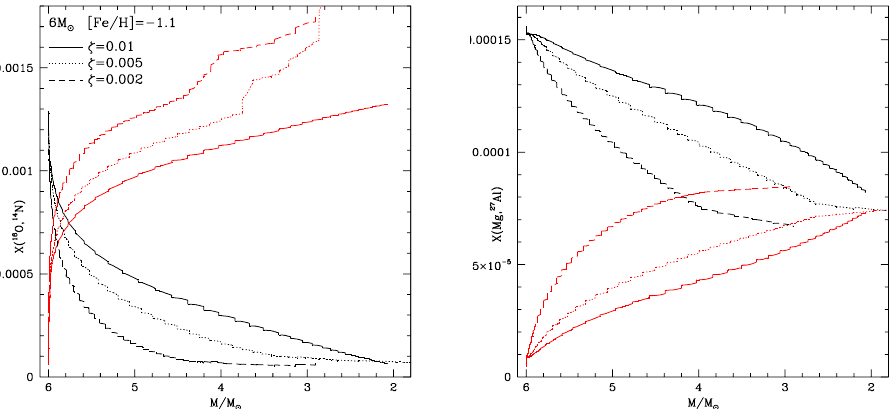
Figure 6. Variation of the surface chemical composition of a 6 M (cid:12) model star with the same chemical composition of the stars belonging to the 1G of the cluster NGC 6402, as a function of the current mass of the star. The different lines refer to evolutionary sequences calculated by adopting different values of the mass-loss parameter η R . The evolution of the surface mass fraction of 14 N and 16 O are shown in the left panel , whereas those of Mg and 27 Al are reported in the right panel